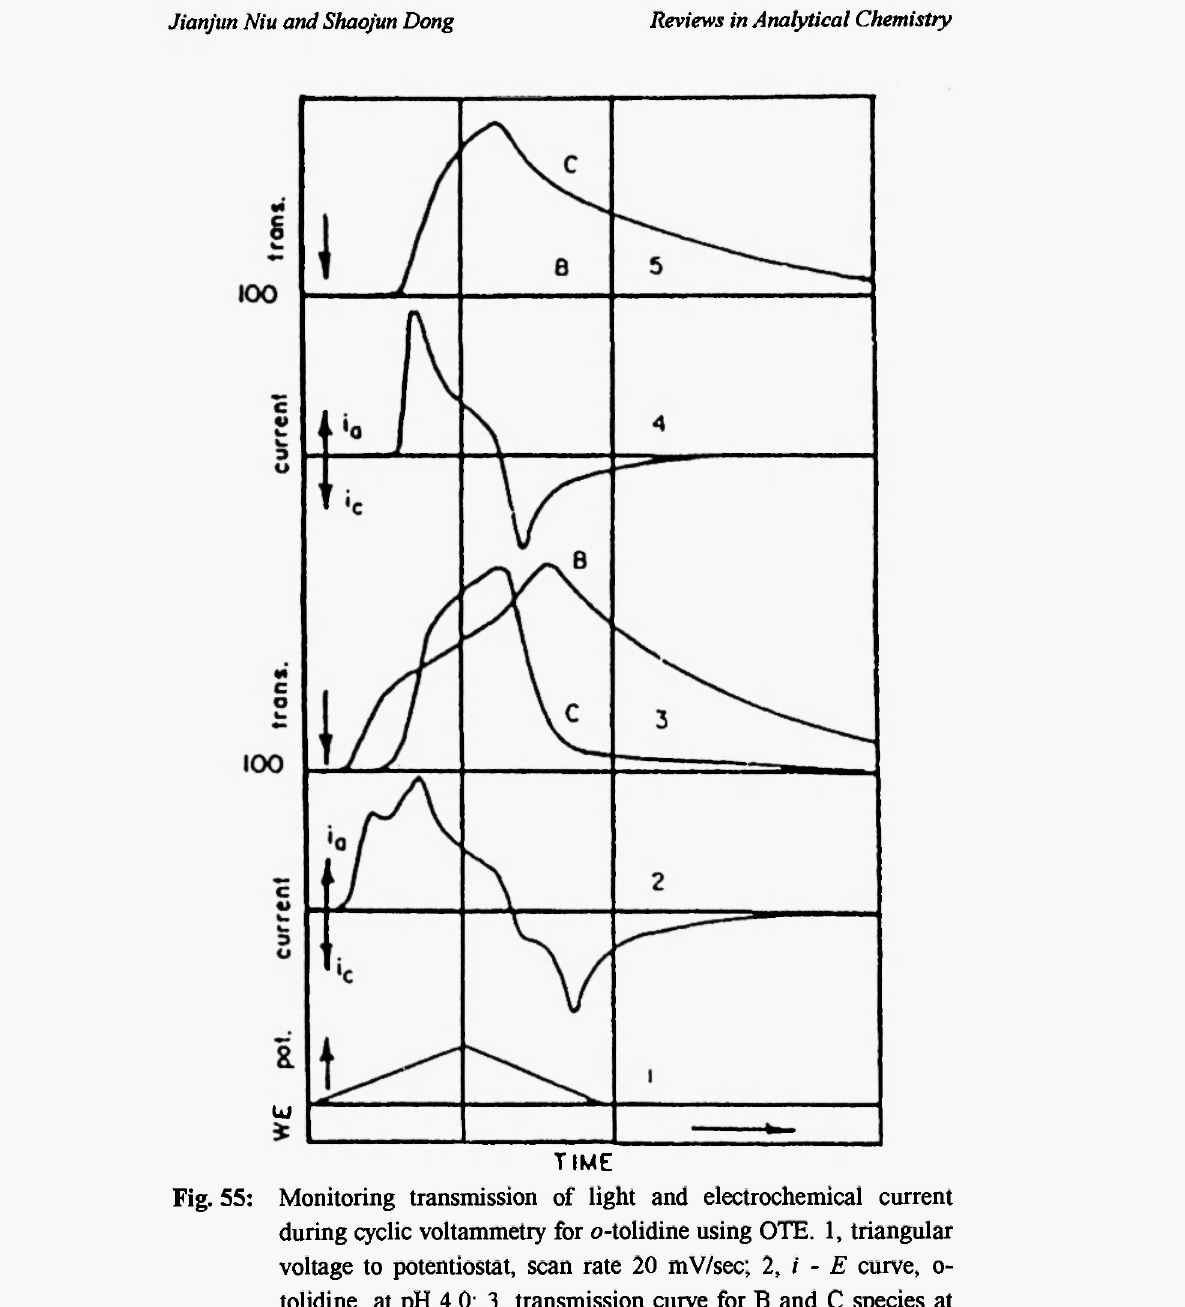
Fig. 55: Monitoring transmission of light and electrochemical current during cyclic voltammetry for o-tolidine using OTE. 1, triangular voltage to potentiostat, scan rate 20 mV/sec; 2, i - Ε curve, o- tolidine at pH 4.0; 3, transmission curve for Β and C species at 630 and 437 nm, respectively; 4,i - Ε curve, o-tolidine at pH 2.0; 5, same as 3 except pH 2.0. (From Ref.